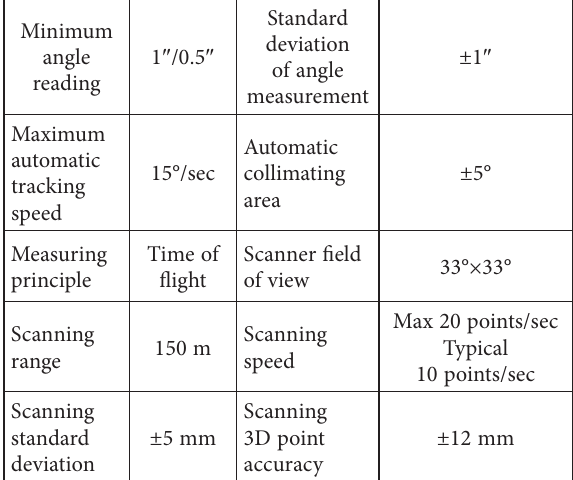
Table 3. Specifications of the Topcon image station IS-201